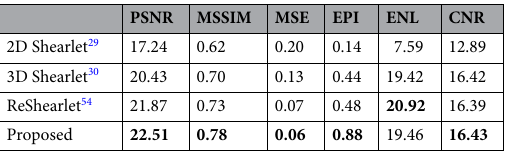
Table 1. Ablation experimental results based on PSNR, MSSIM, MSE, EPI, ENL and CNR. The bold numbers mean the best result compared with other